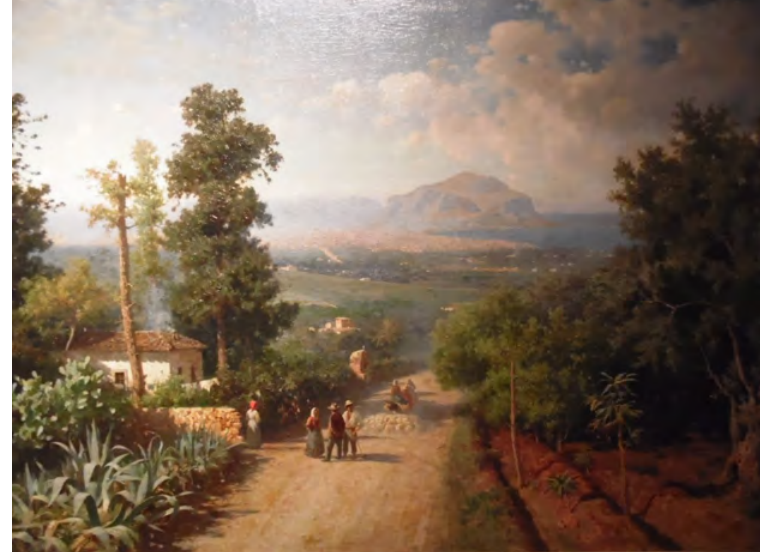
Figure 5. Francesco Lojacono (Palermo, 16 maggio 1838 –Palermo, 28 febbraio 1915), Ph.: Muesse - Galleria d’Arte Moderna(Palermo-Italy). Youcan see the centenarian olive tree on the right. The poplars on the left. Inthe background the dark green of the first citrus